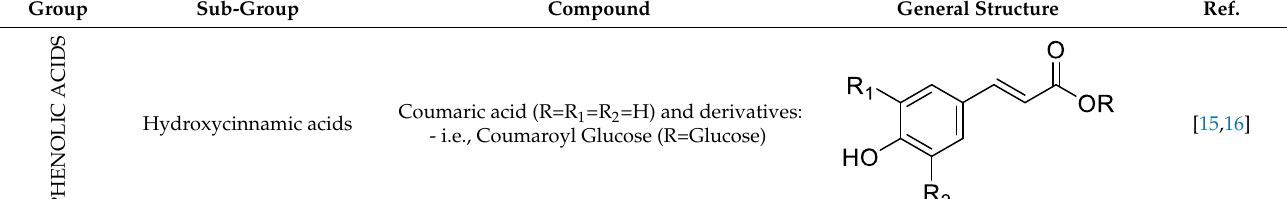
Table 2. Phenolic compounds identified in C. album leaves. Compound General Structure Ref.